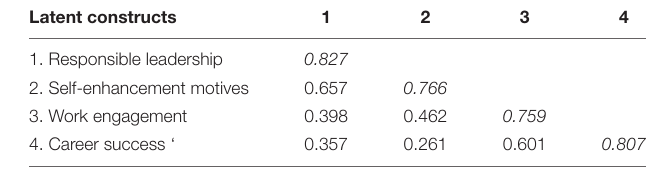
TABLE 2 | Discriminant validity test results.